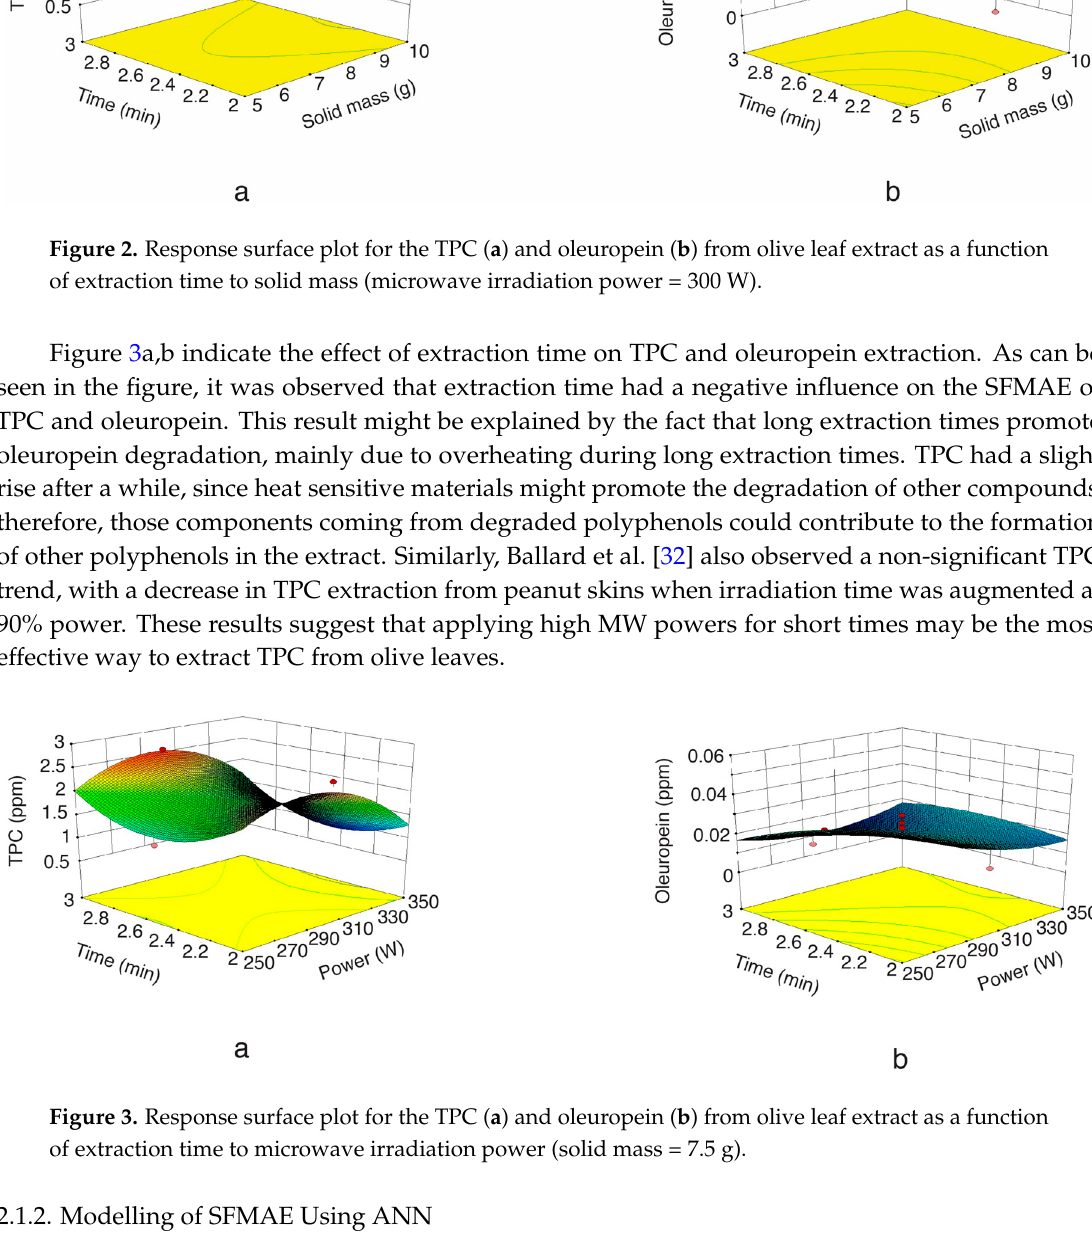
Figure 4. The feed-forward multilayer artificial neural network model with a back-propagation learning algorithm. The predicted values after ANN modelling are shown in Table 1.